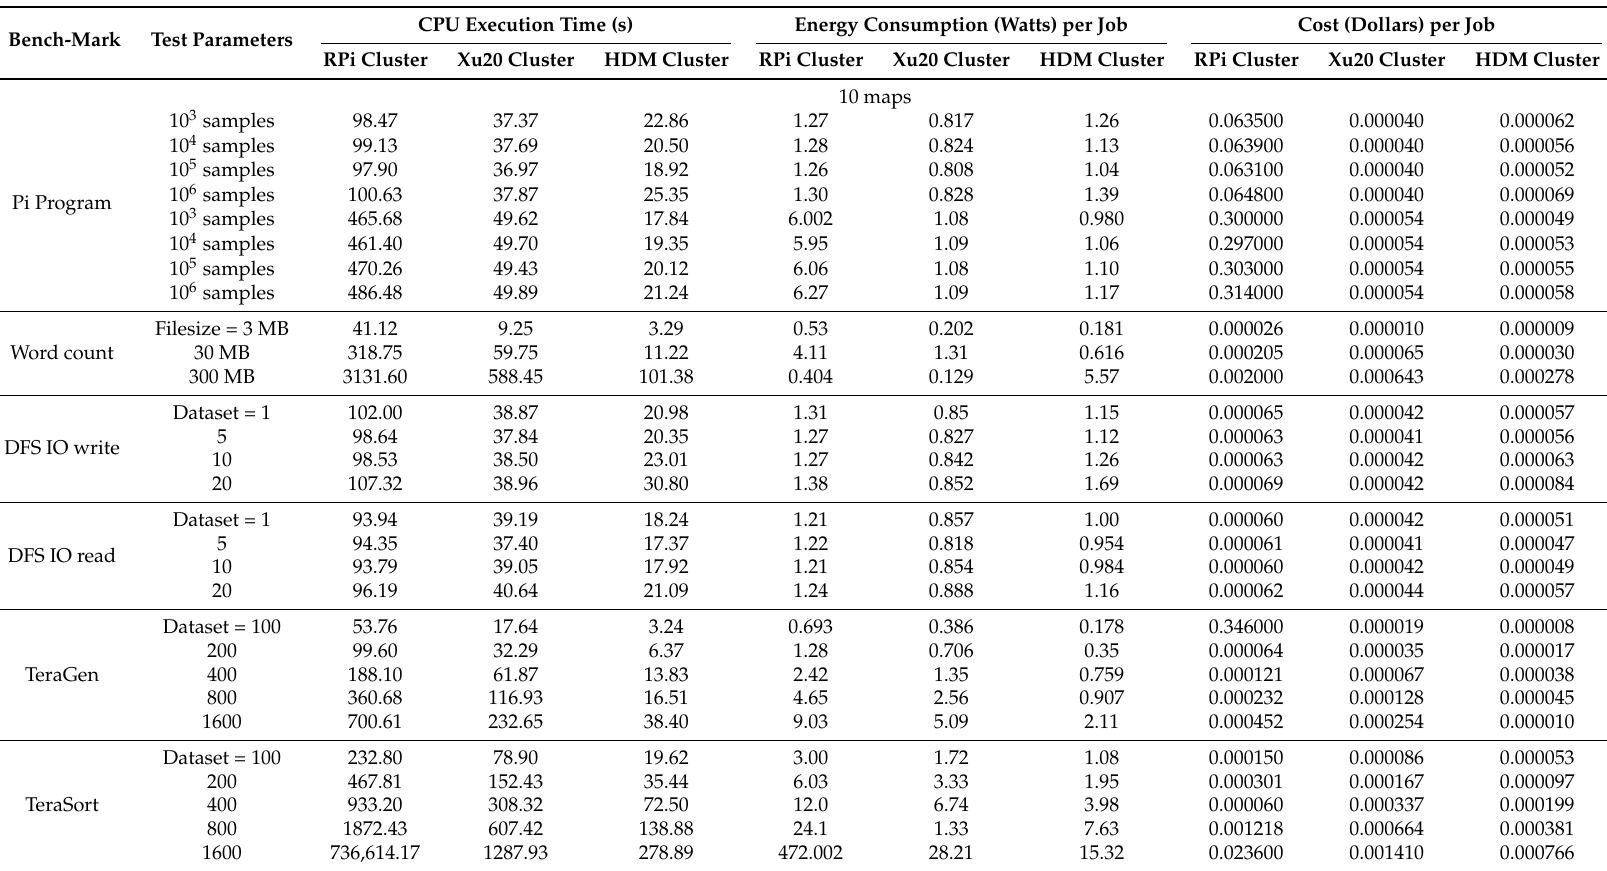
Table 9. Average CPU Execution times for TeraSort and TeraGen Benchmarks on the